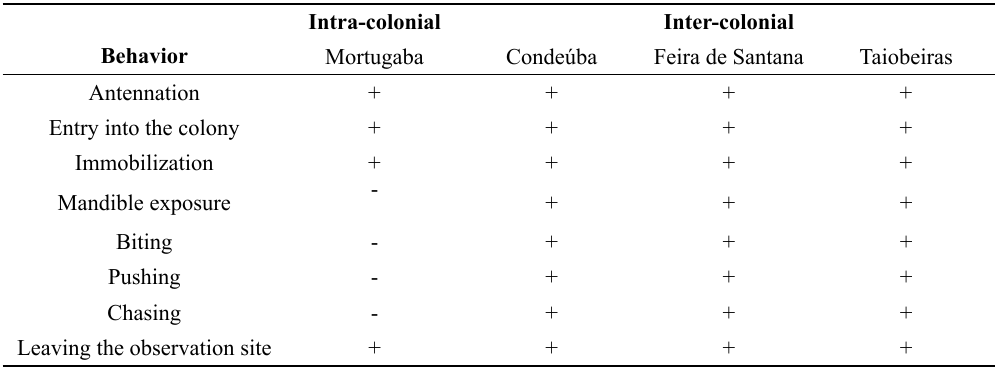
Table 1. Behavioral acts observed in N. testaceicornis workers in the process of discrimination of another individual and their respective occurrence